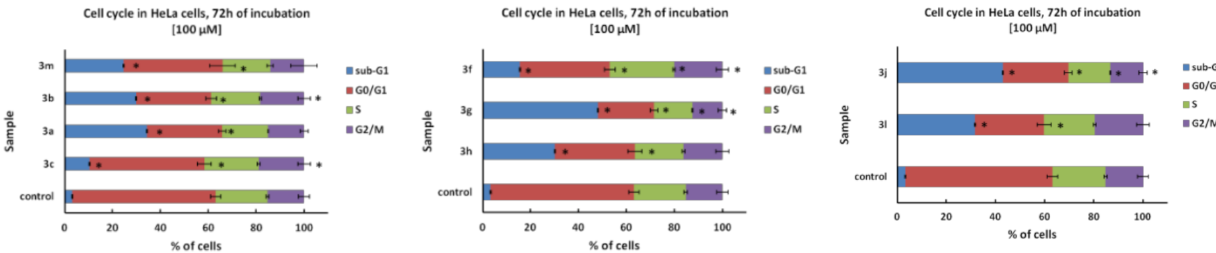
Figure 7. Cell cycle in HeLa cells after a 72 h incubation with compounds with the concentration of 100 µ M. The results were presented as mean value ± SD. The statistical analysis was based on a t-test, and a p -value less than 0.05 was considered statistically significant in comparison to the untreated controls (indicated with a